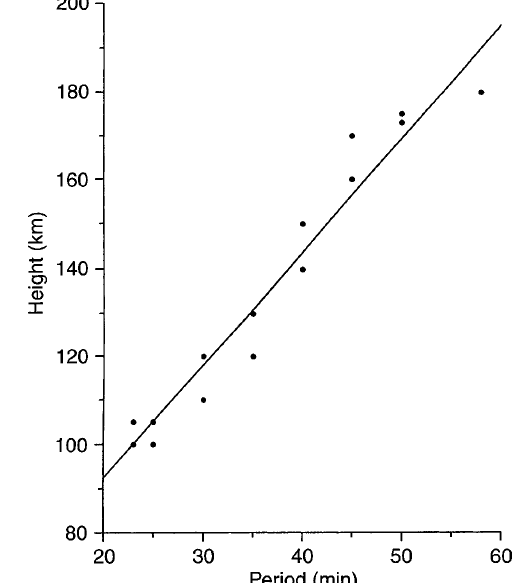
Fig. 6. Variation of height of the occurrence of Es layers with the periodicity of the gravity waves